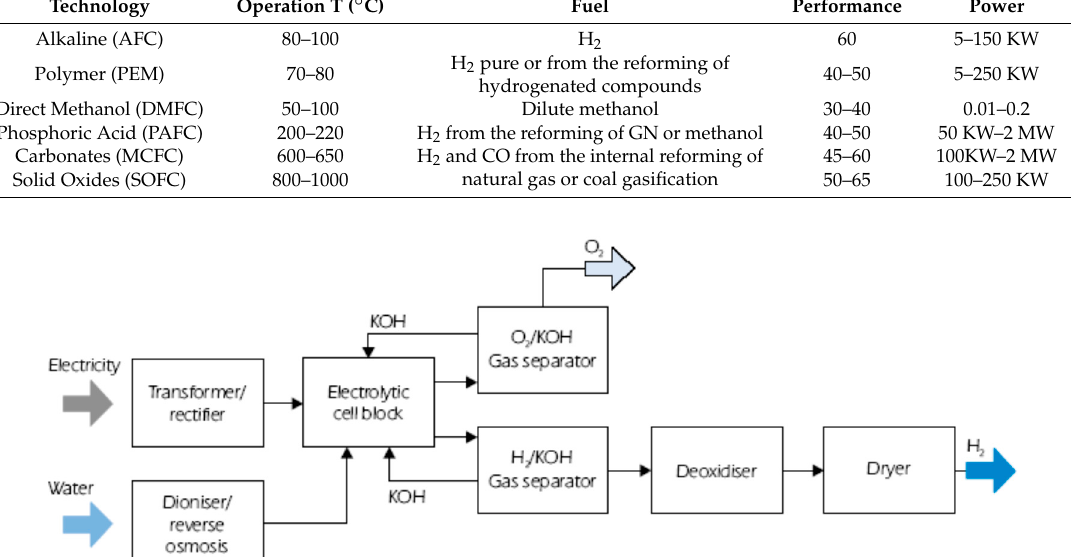
Figure 2. Electrolysis process flow diagrams [13]. It is important to highlight that hydrogen production using pressurized water requires less power than when hydrogen compressors are used. The difference is about 15% kW, which